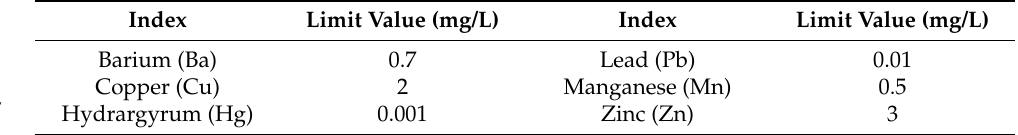
Table 1. WHO standards on the concentration of heavy-metal ions in drinking